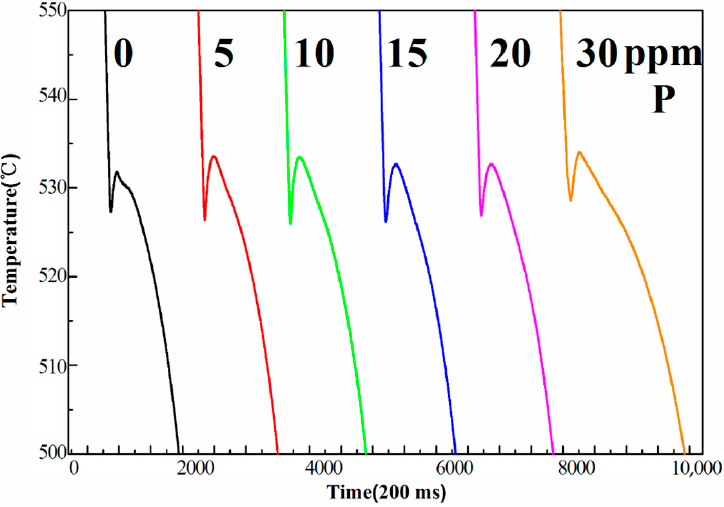
Figure 10. Cooling curves of high-purity al-40Zn-5Si alloy with different contents of P element.